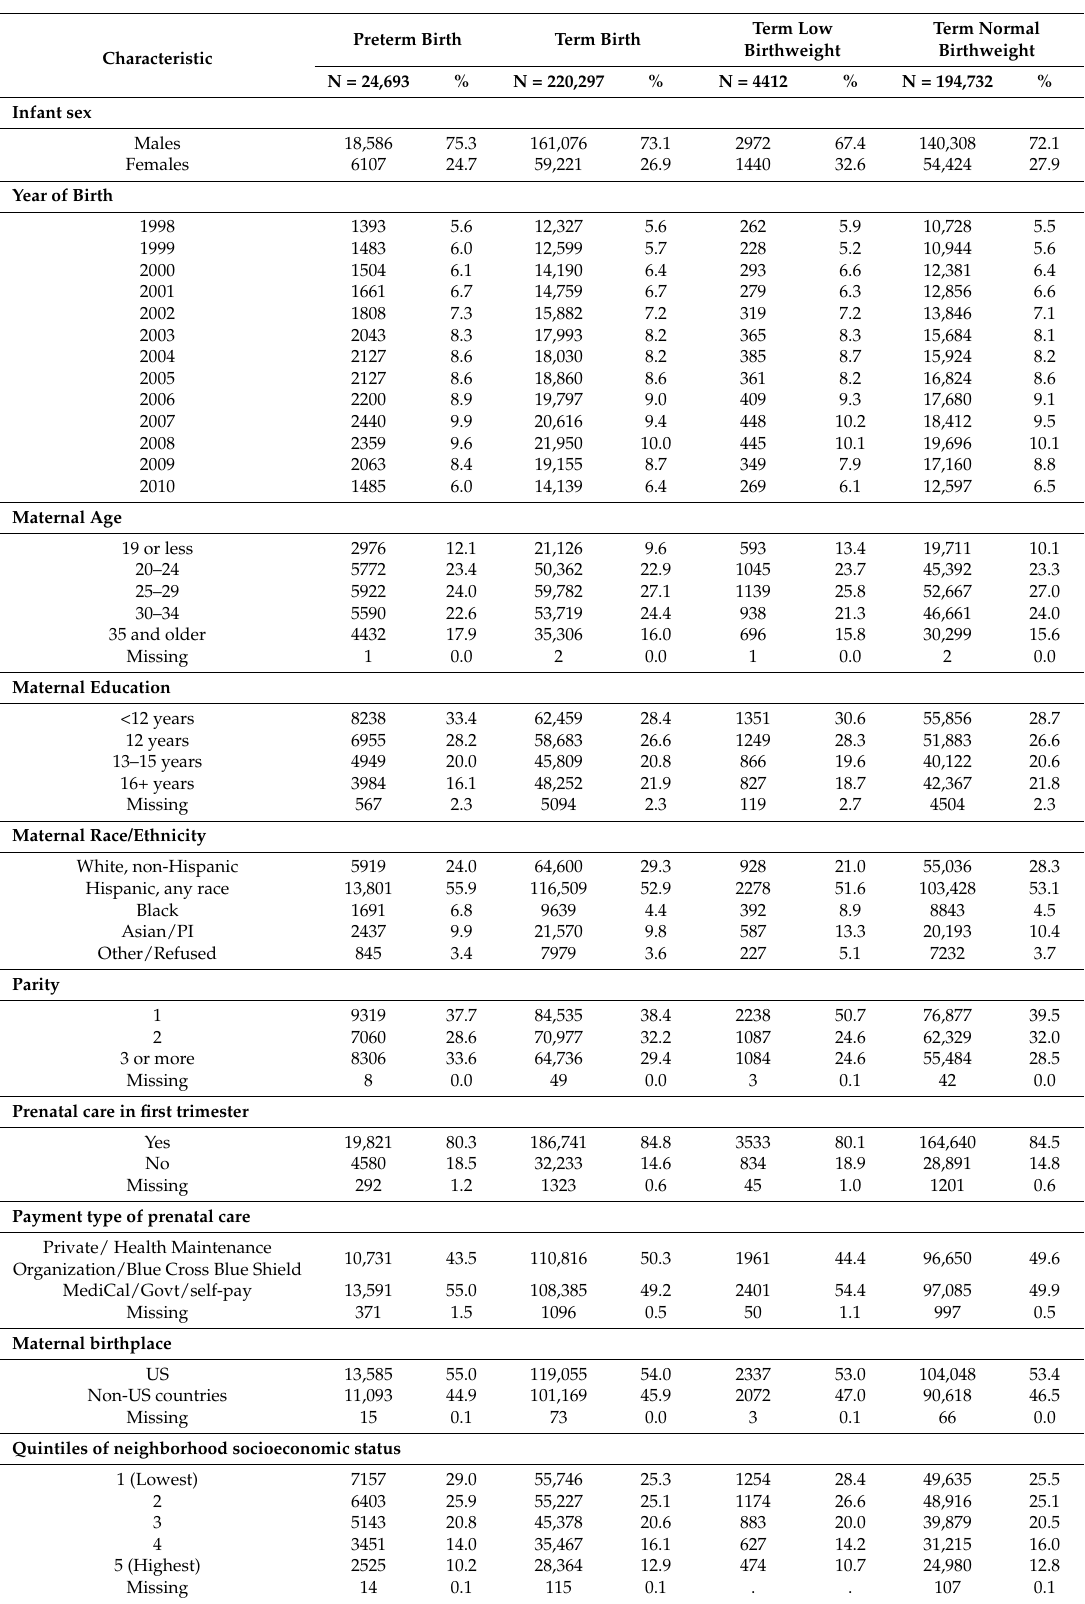
Table 1. Demographic and pregnancy characteristics of the study population in agricultural regions,